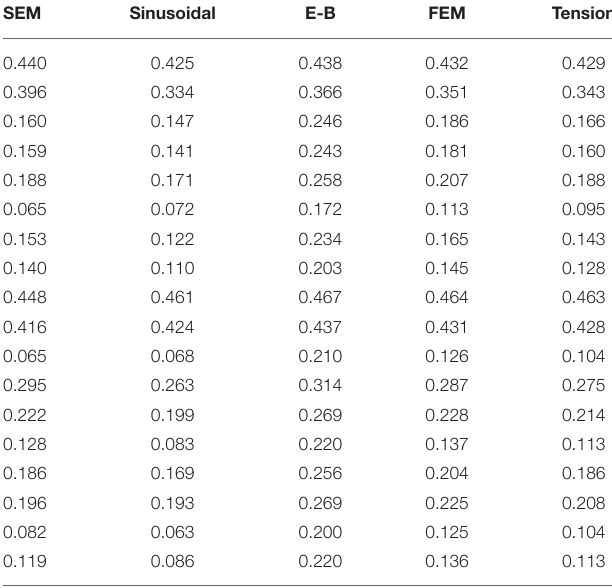
TABLE 4 | Position values for 20 µ m beam.